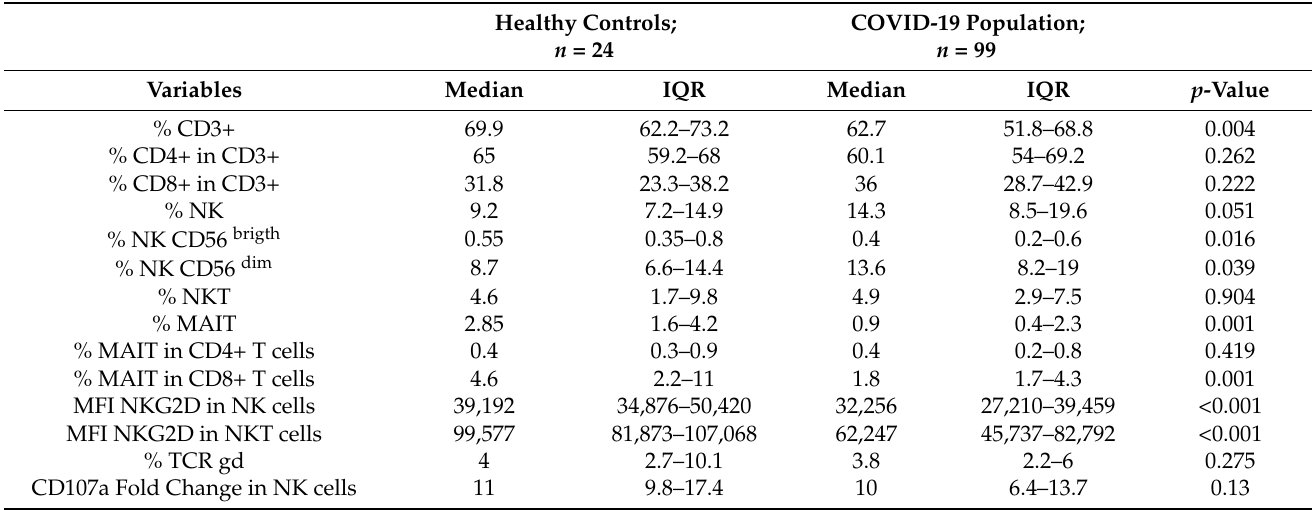
Table 1. Innate immunological profile in healthy controls compared to COVID-19 patients. Healthy